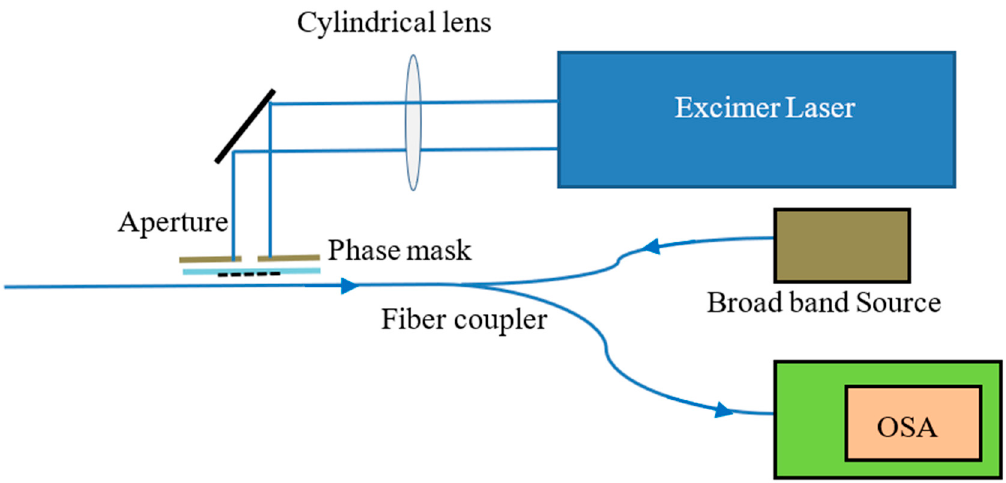
Figure 1. Experimental setup for inscription of Fiber Bragg Gratings.